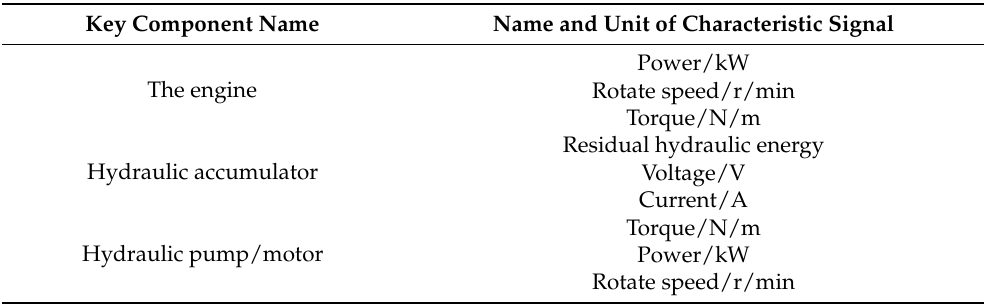
Table 2. Extraction of characteristic signals for key components of the power system of the hydraulic hybrid electric vehicle.